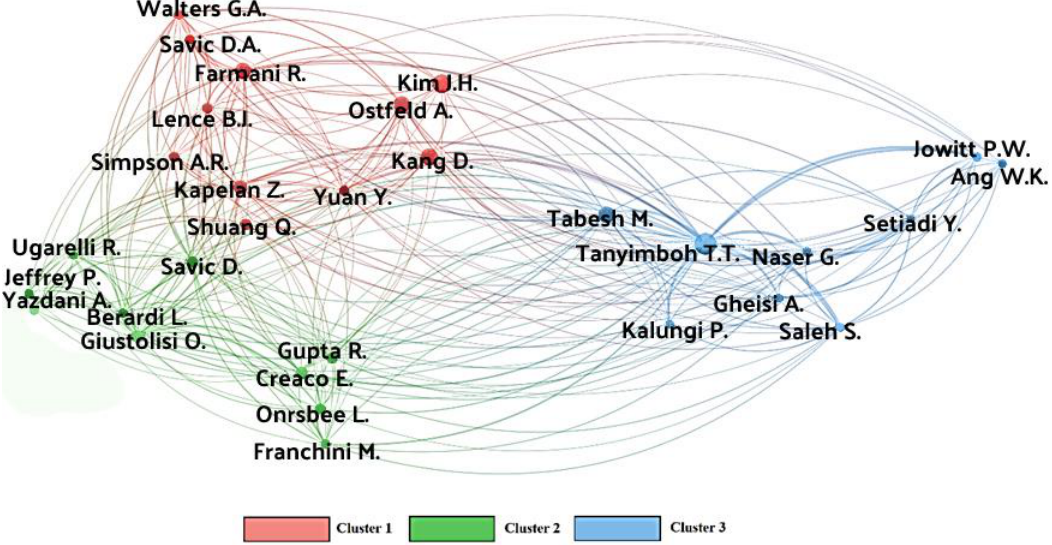
Figure 5. A network map of co-authorship for different authors, node size represents the number of publications for each author and the link thickness represents the collaboration extent.